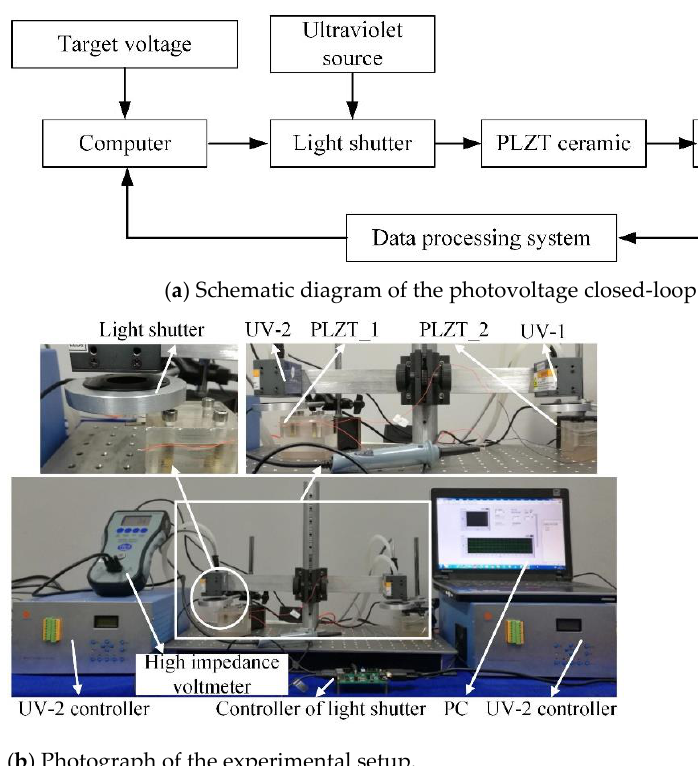
Figure 19. The experimental setup of the photovoltage closed-loop control: ( a ) Schematic diagram of the photovoltage closed-loop control; ( b ) Photograph of the experimental setup.